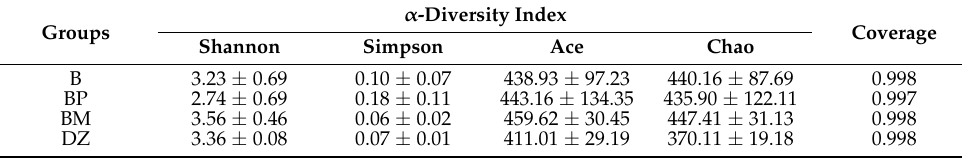
Table 2. α -diversity indices of bacterial communities in shrimp culture systems.